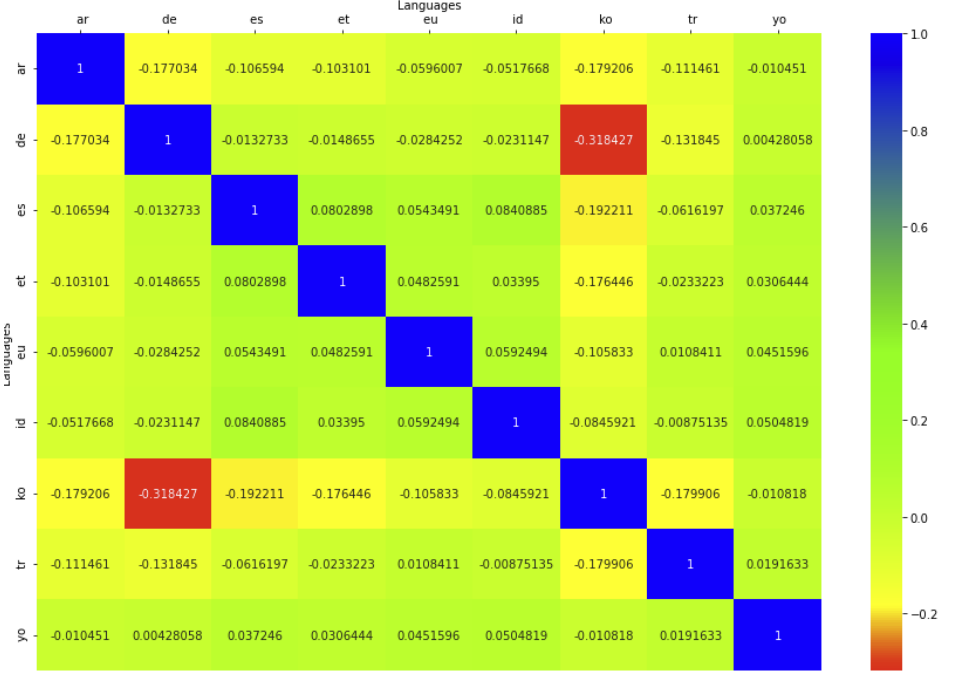
Figure 9. Coincidences between languages in a correlation